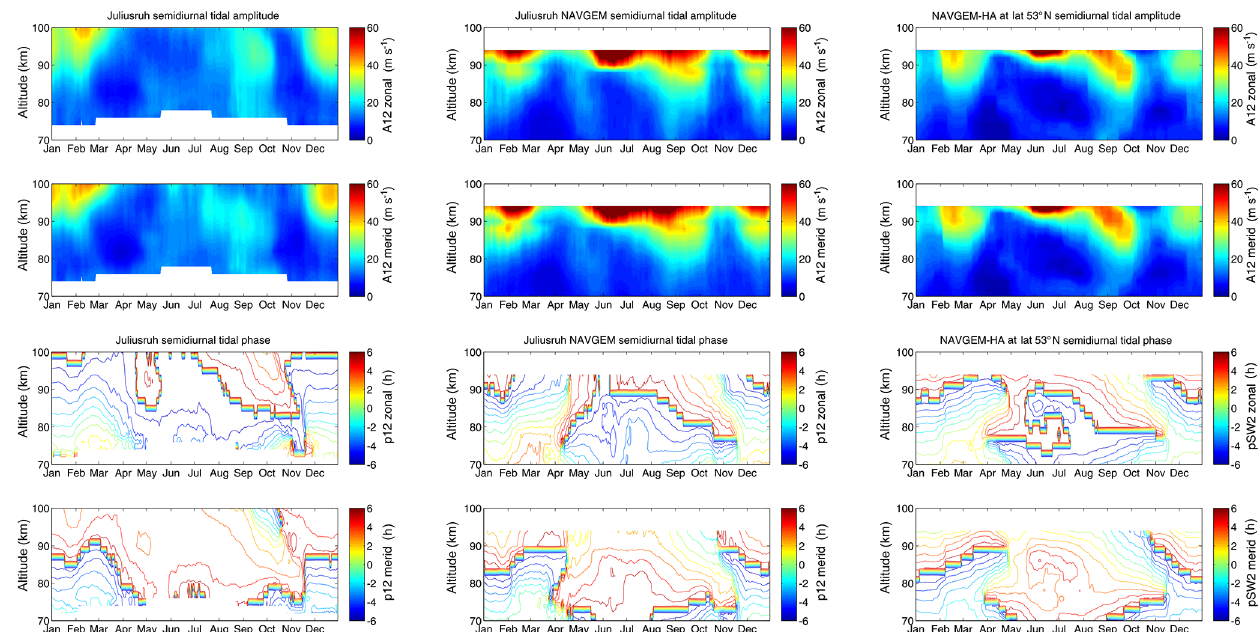
Figure 4. Same as Fig. 3 but for